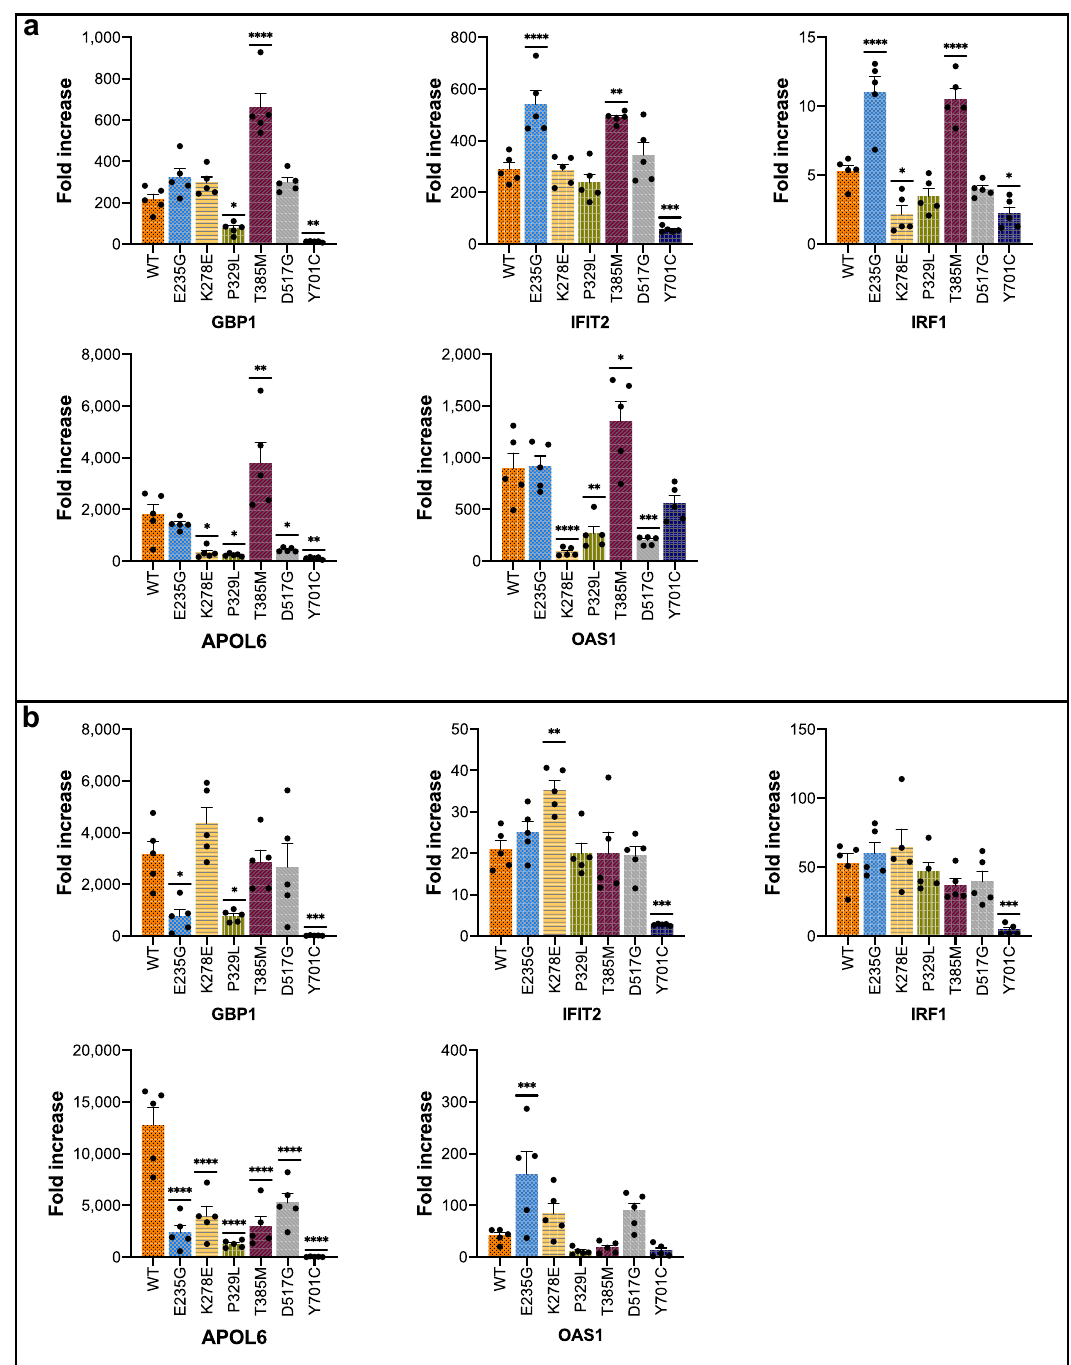
Fig. 4 Relative gene expression of interferon-stimulated genes (ISG) following IFN α or IFN γ stimulation. mRNA expression levels were measured for fi ve ISG ( GBP1, IFIT2, IRF1, APOL6, OAS1 ) at baseline and following 6 h of stimulation with IFN α ( a ) or IFN γ ( b ). Expression levels were normalized to housekeeping GAPDH and plotted as fold increase from baseline. Pooled data from at least fi ve experiments are presented. Data are represented as mean ± standard error of mean. Statistical analysis: one-way ANOVA with Dunnett ’ s post-hoc test (* p < 0.05, ** p < 0.01, *** p < 0.001, **** p < a manner which is independent of external cytokine stimuli, and activation of many ISG, in a manner which may be both possibly independent (or only partially dependent) of pSTAT1. cytokine-dependent and independent. It does so by acting both While cytokine-dependent activation of pSTAT1 has been as a homodimer, and in complex with other transcription factors regarded as the canonical pathway of STAT1 signaling, a well- such as U-STAT2, and IRF9 (refs. 7,61 – 65 ). It is therefore possible that established transcriptional role exists for unphosphorylated STAT1 mutated, unphosphorylated STAT1 molecules may result in (U-STAT1) 61 – 64 . U-STAT1 mediates the constitutive baseline differential transcriptional activity at baseline, causing an